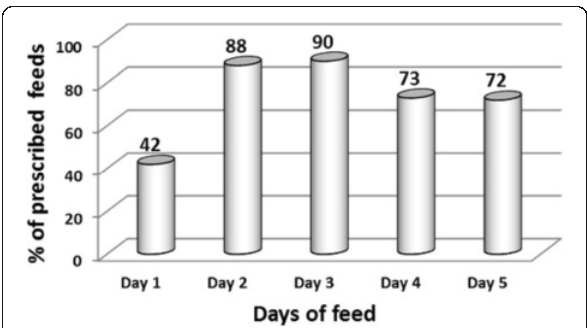
Fig. 28 (abstract A55). % of feeds received over days